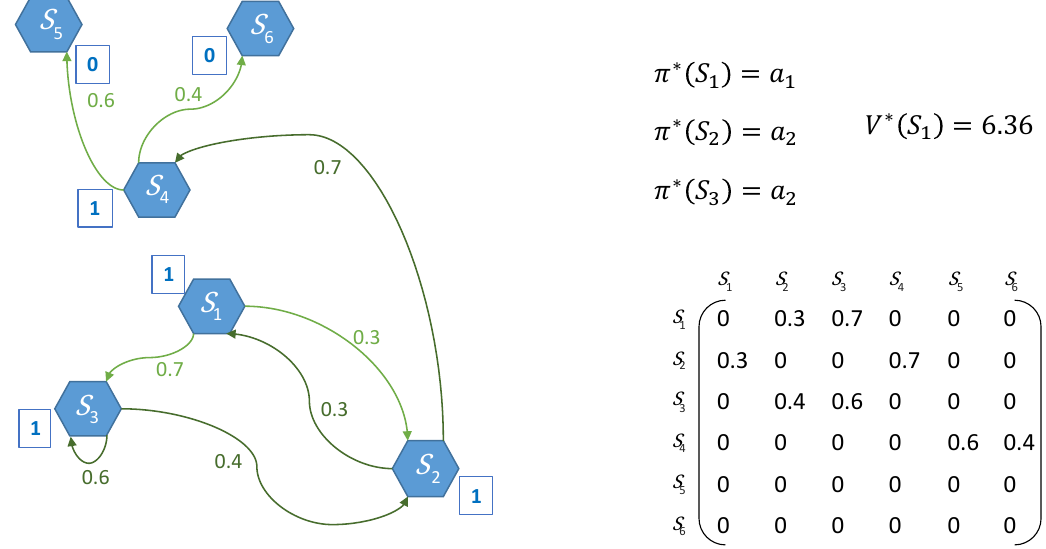
Figure 2. An example of a Markov chain (MC), as the result of selecting one policy in the setup of Figure 1 ( left ). The policy displayed on the right-hand side is the optimal policy for this MDP, when starting in S 1 . The transition probabilities for the MC are shown in the matrix ( right